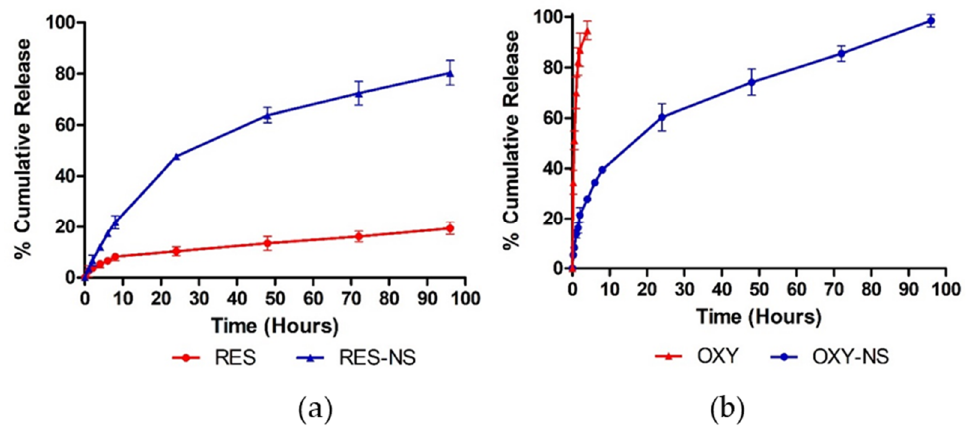
Figure 8. The release profile of ( a ) RES vs. RES-NS and ( b ) OXY vs. OXY-NS.